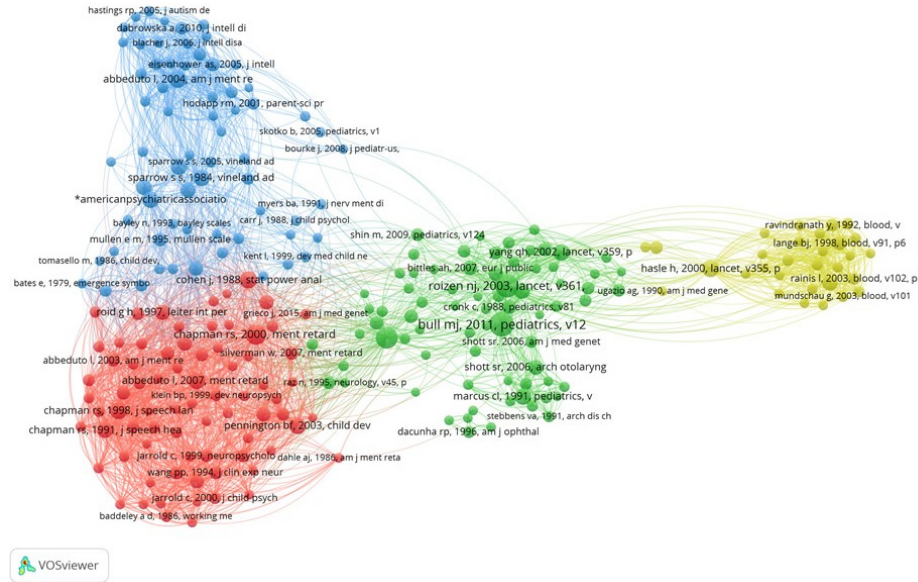
Figure 2. Citation network of cited references. Table 3. Documents with the highest eigenvector centralities in the cited reference network.